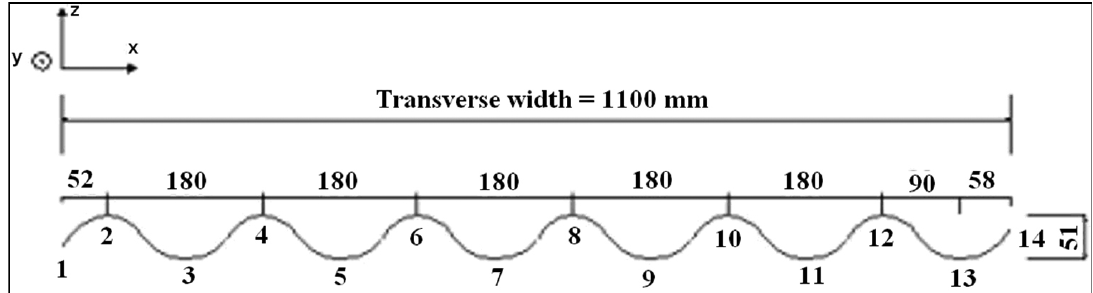
Figure 1. Cross section of the sheets considered in the numerical models.